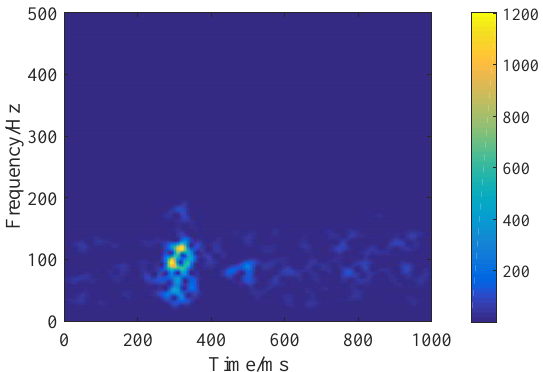
Figure 5. An example of a spectrogram